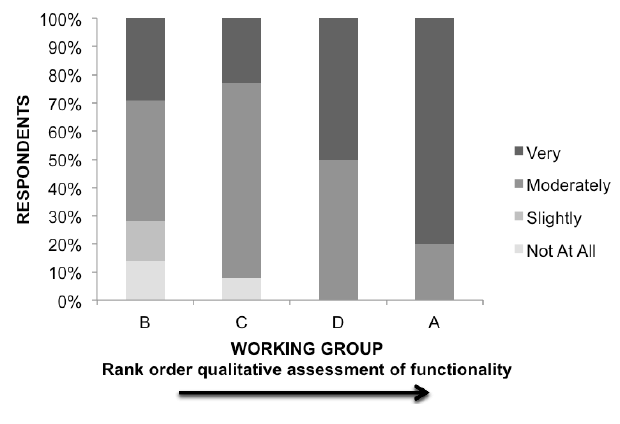
Fig. 1 . Comparison of quantitative (y-axis: degree that the group is meeting its goals on a scale of 1 = not at all to 4 = very) and qualitative (x-axis) measures of working group